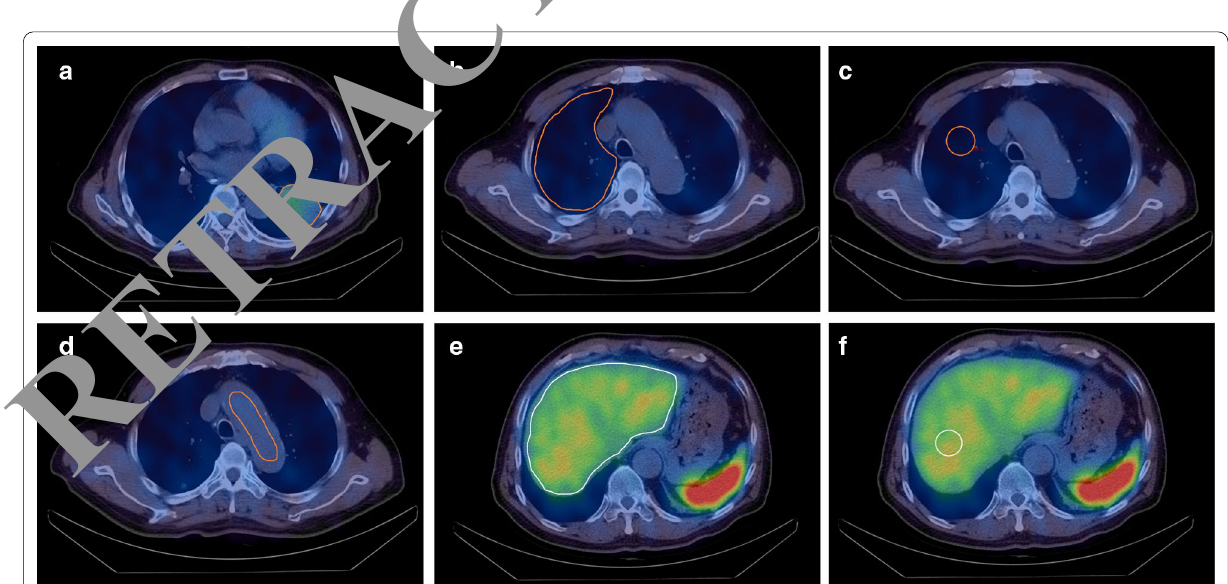
Fig. 1 Image analysis using ROI max scoring of [ 99m Tc]NM-01 SPECT/CT of: primary left lower lobe tumour, IHC PD-L1 65% ( a ), freehand; unaffected lung tissue freehand ( b ) and using a 3-cm sphere at level of the aortic arch ( c ); blood pool reference tissue ( d ); liver reference tissue freehand ( e ) and using a 3-cm sphere at the axial level of the gastroesophageal junction ( f